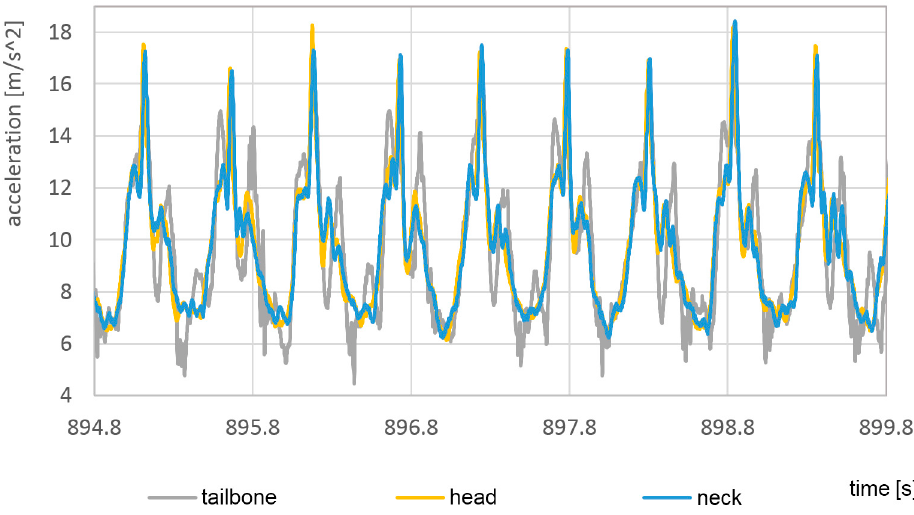
Figure 28. The vertical component of the acceleration of head, neck, and tailbone during the passage in sports shoes.